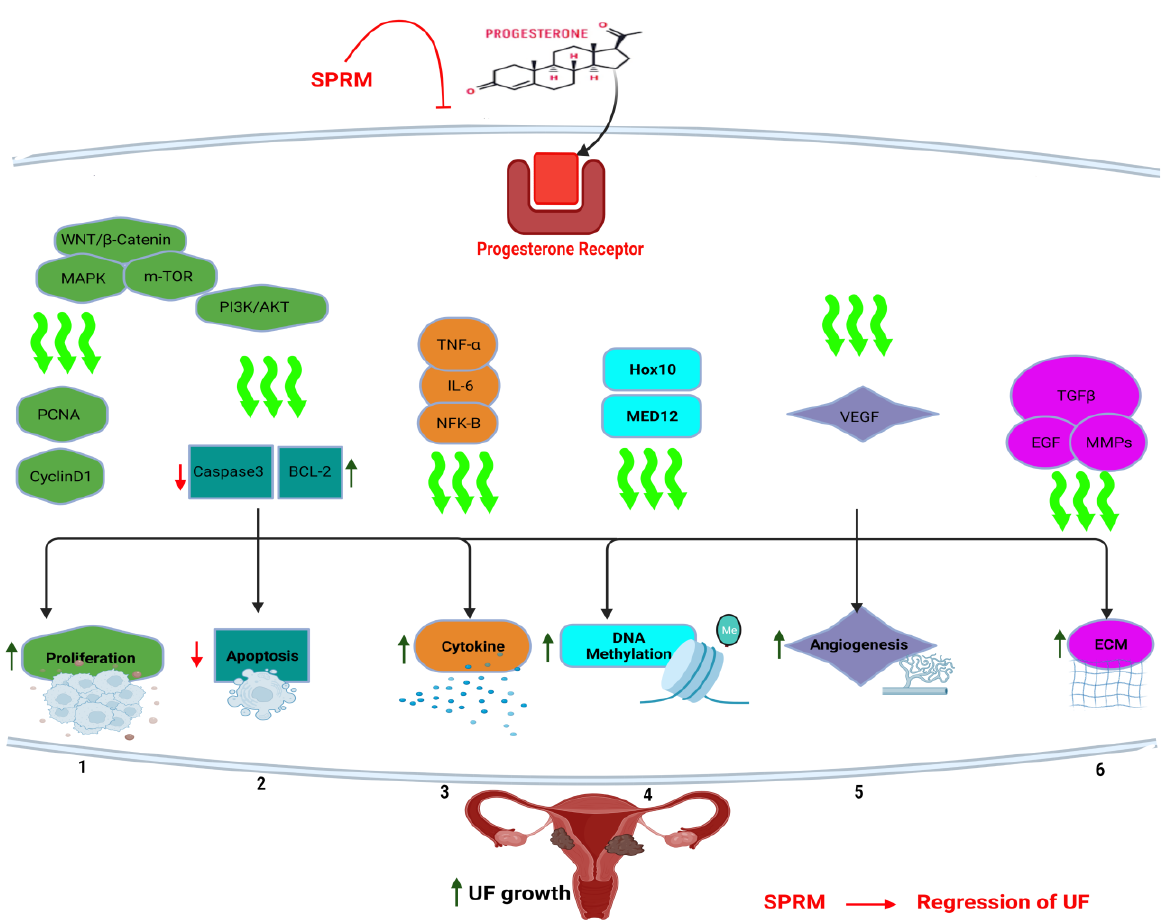
Figure 1 . Progesterone signaling in uterine fibroid pathogenesis. Progesterone binds to its own receptor (PR), with subsequent activation of several signaling pathways including (wingless-related integration site) WNT/β-catenin pathway, mitogen-activated protein kinases (MAPK), and phosphoinositide 3-kinase (PI3K)/Ak strain transforming (AKT)/mammalian target of rapamycin (mTOR). This resulted in activation of cell proliferation, apoptosis inhibition, cytokine release, angiogenesis induction, and extracellular matrix (ECM) accumulation towards uterine fibroid (UF) tumor growth. Selective progesterone receptor modulators (SPRM) such as ulipristal acetate can interfere with progesterone signaling and induce tumor regression. PCNA: proliferating cell nuclear antigen. TNF-α: tumor necrosis factor alpha, IL-6: interleukin 6, NF-kB: nuclear factor kappa B, MED12: mediator complex subunit 12, Bcl- 2: B-cell lymphoma-2, TGF-β: transforming growth factor beta, MMP: matrix metalloproteinase, EGF: epidermal growth factor.